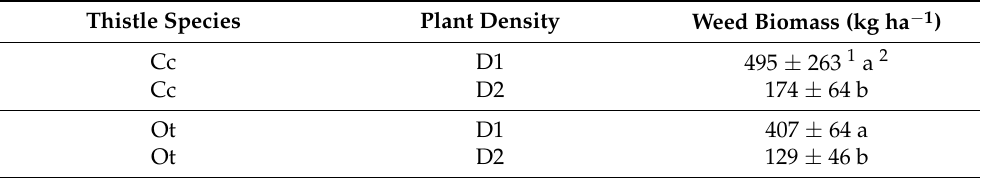
Table 7. Estimated biometric marginal mean differences calculated with the Bonferroni adjustment between the compared density treatments and weed biomass (kg ha − 1 ). Thistle Species Plant Density Weed Biomass (kg ha − 1 ) Cc D1 495 ± 263 1 a 2 Cc D2